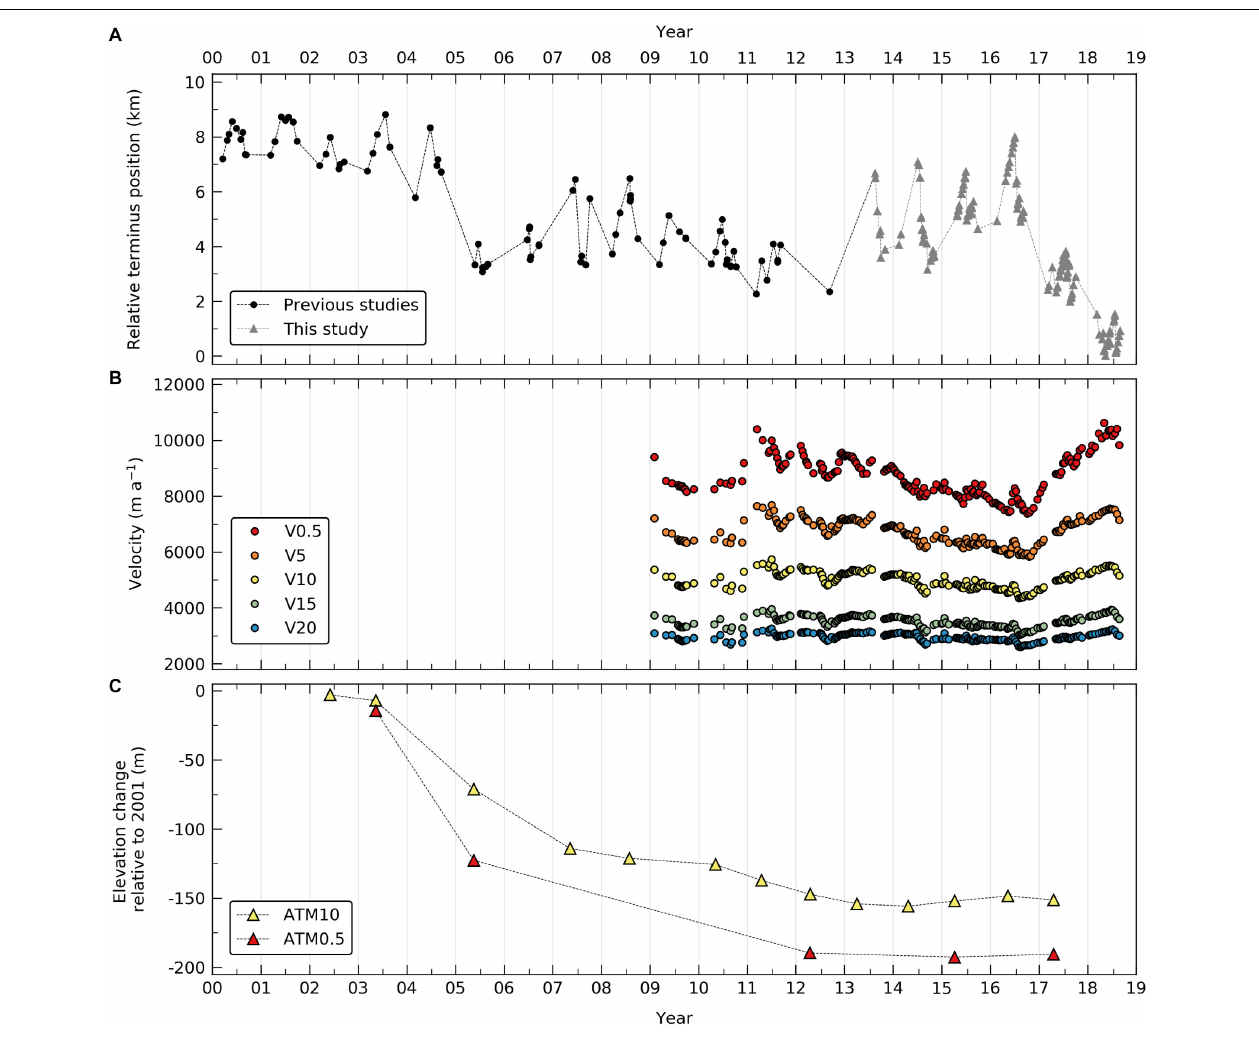
FIGURE 3 | Time series of terminus, velocity and surface elevation change for Kangerlussuaq. (A) Change in terminus position between 2000 and 2018, plotted relative to the most retreated ice front (16 May 2018). (B) Plots of velocity for selected points along the center line as shown in Figure 1 . Points were coded such that the numerical designation (e.g., V5) indicates the distance in kilometers from the most retreated ice front (16 May 2018). (C) Surface elevation change relative to 2001 for locations marked by the white star ( ∼ 10 km from the most retreated ice front) and red star ( ∼ 0.5 km from the most retreated ice front) in Figure 5